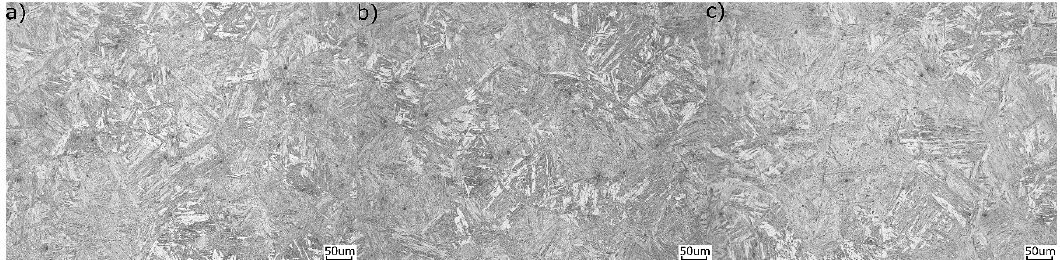
Figure 5. Microstructure of steel after isothermal holding in bainite region: ( a ) 400 °C, 15 min; ( b ) 400 °C, 180 min; ( c ) 350 °C, 15 min.